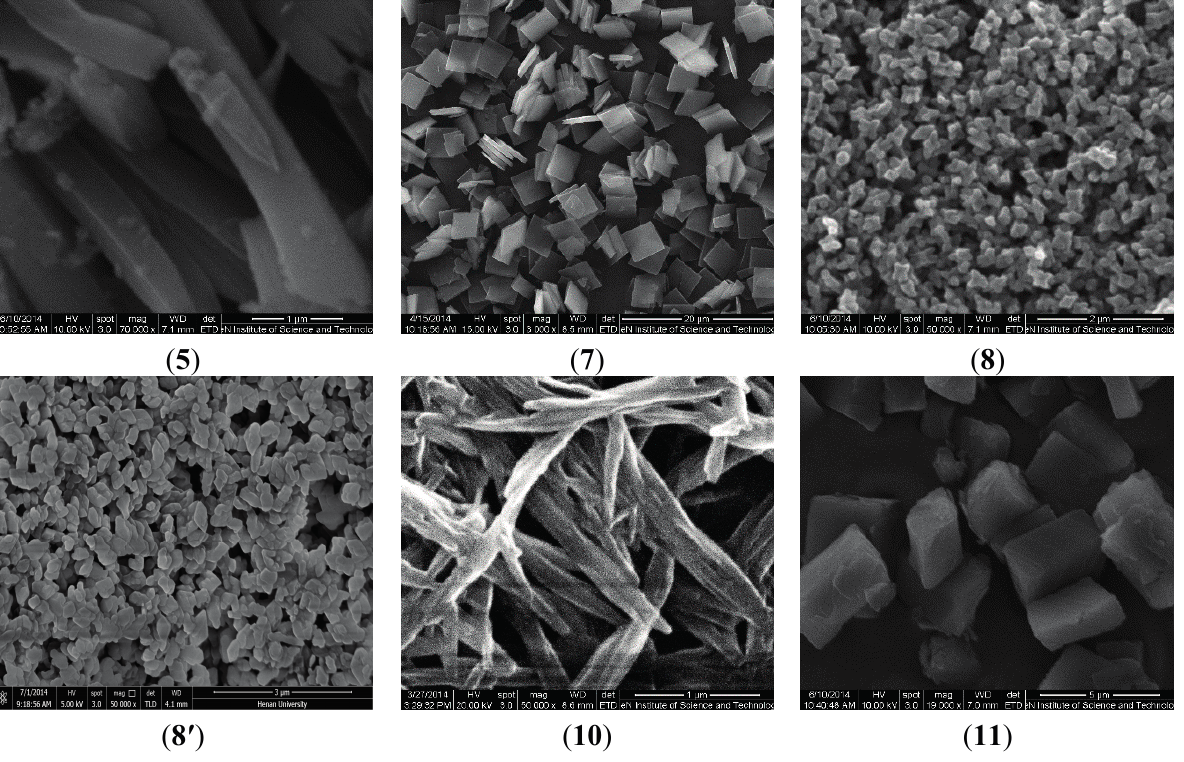
Figure 1. SEM images for compounds ( 1 , 2 , 4 , 5 , 7 , 8 , 8 ʹ , 10 and 11